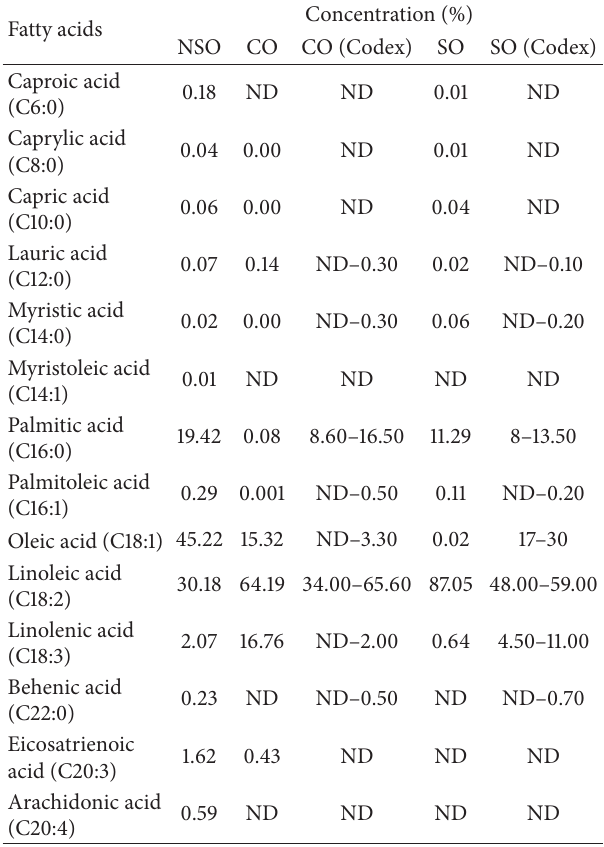
Table 2: The composition of fatty acids in NSO, CO, and SO. Fatty